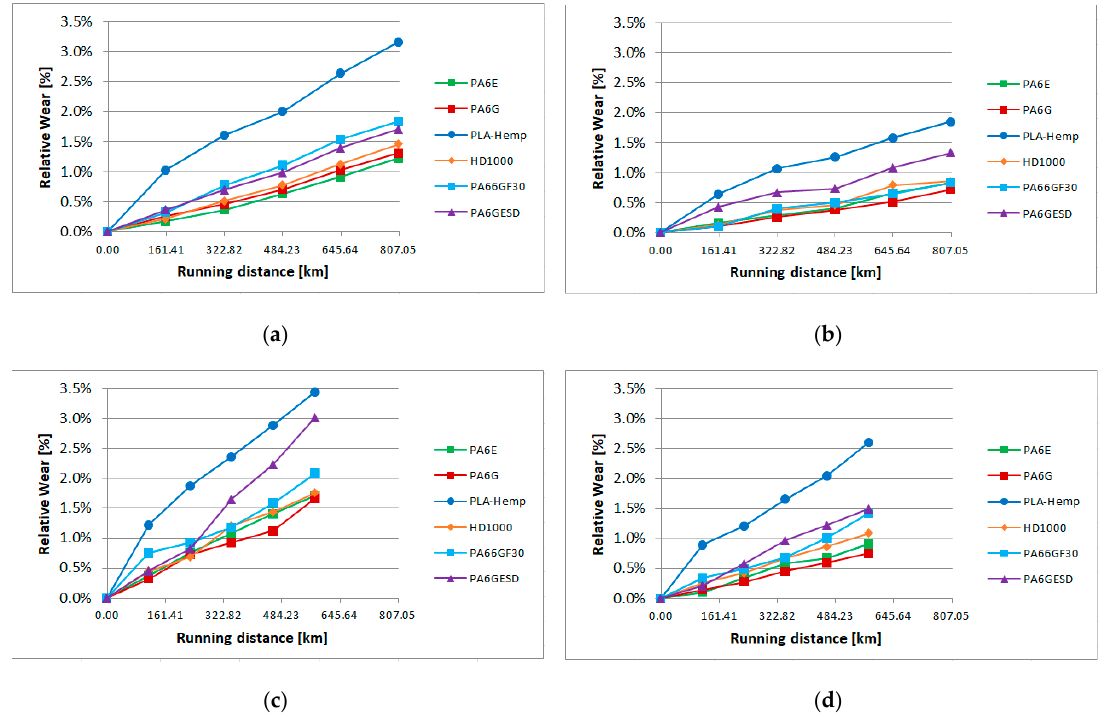
Figure12. Therelativewearofthetestedmaterialsinloamysoil-basedslurry( a )position1, ( b )position2, Figure 12. The relative wear of the tested materials in loamy soil-based slurry ( a ) position 1, ( b ) ( c ) position 3, ( d ) position 4 (Figure position 2, ( c ) position 3, ( d ) position 4 (Figure 3).